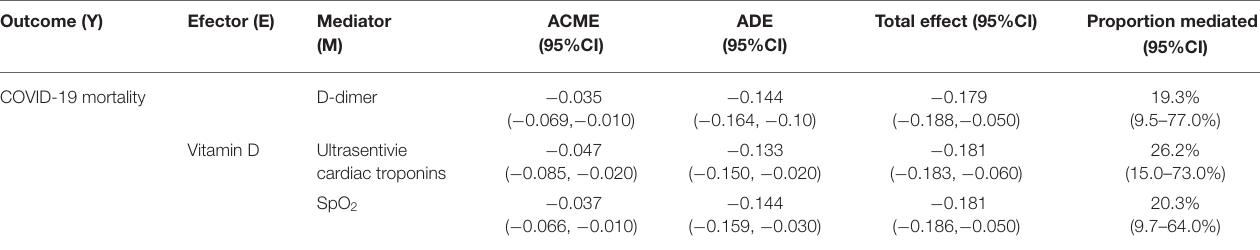
TABLE 4 | Causal mediation analyses predicting the effect of Vitamin D levels (E) mediated by elevated D-dimer, ultrasensitive cardiac troponins or low SpO2 (M) on severe COVID-19 and mortality (Y), adjusted by gender, age, BMI and epicardial fat. Outcome (Y) Efector (E) Mediator ACME (M) (95%CI) COVID-19